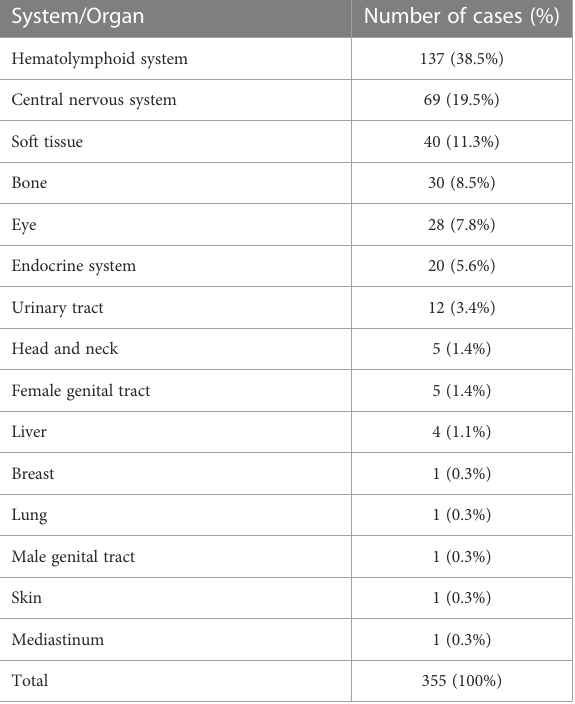
TABLE 4 Frequency of site-speci fi c tumors among pediatric Libyan patients treated at KHCC between 2006 and 2019.